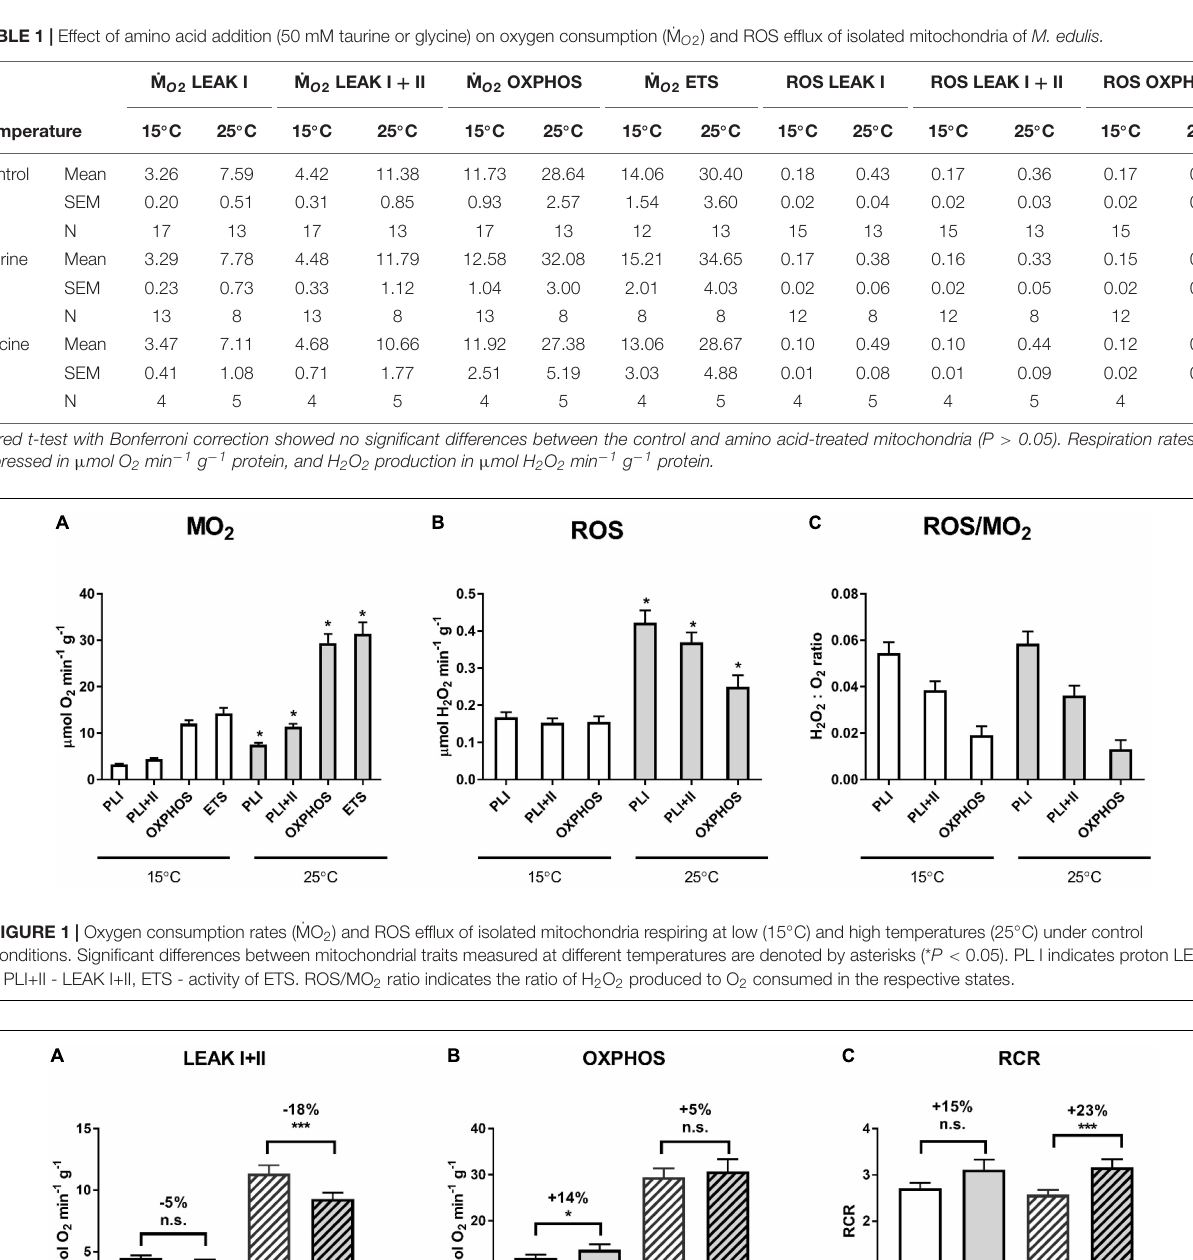
1 (2.7-fold), the catalytic subunit of mtDNA polymerase γ (2.4-fold), phosphoenolpyruvate carboxykinase (PEPCK) (2.2-fold) and arginine kinase (1.9-fold) ( Table 2 ). Other upregulated mitochondrial phosphoproteins (involved in